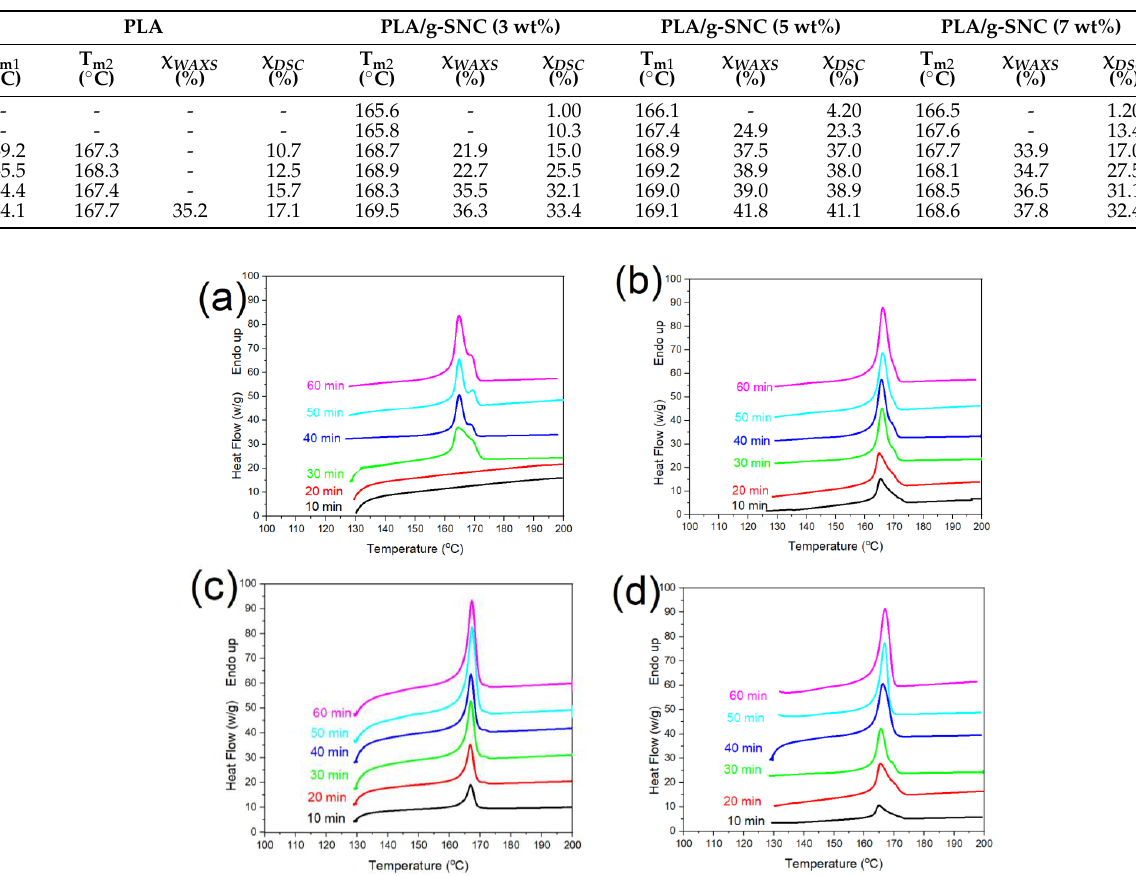
Figure 3. The melting behavior of ( a ) neat PLA, ( b ) PLA/g-SNC (3 wt%), ( c ) PLA/g-SNC (5 wt%), and ( d ) PLA/g-SNC (7 wt%), nanocomposites, which are crystallized for different crystallization times (10 – 60 min) at 𝑇 𝑐 = 130 °𝐶